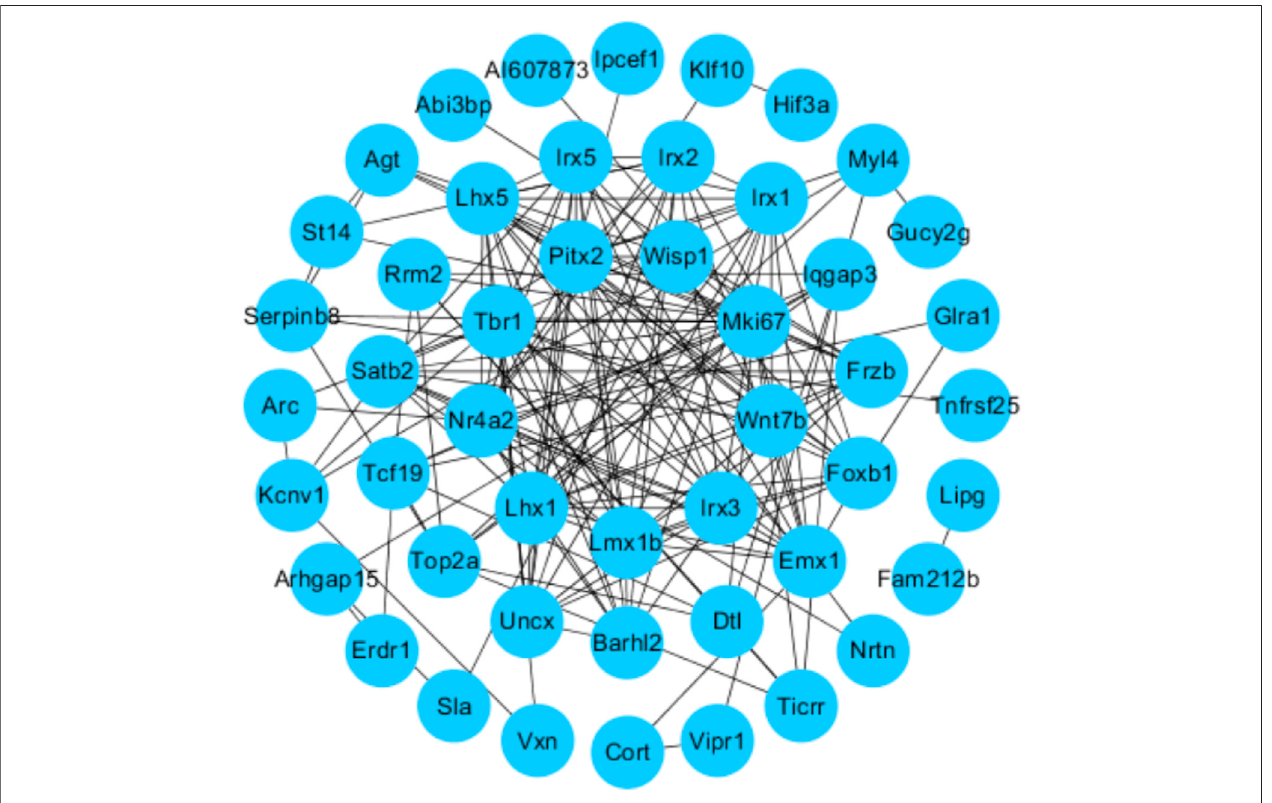
FIGURE6| Protein – proteininteractions(PPI):STRINGanalysiswiththeinteractionscoresetto0.15.Eachnoderepresentstherelevantprotein,theedgeindicates the predicted functional associations, and the number of lines represents the strength of predicted functional interactions between proteins.